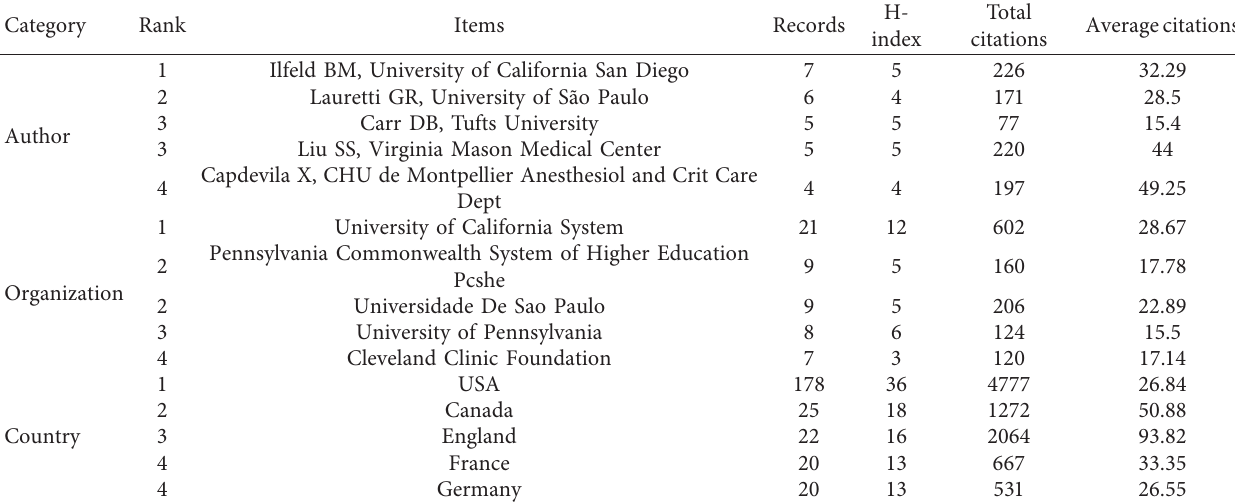
Table 2: The top five high-yield countries, organizations, and authors on analgesics in the treatment of orthopedic postoperative pain from 1985 to 2021.